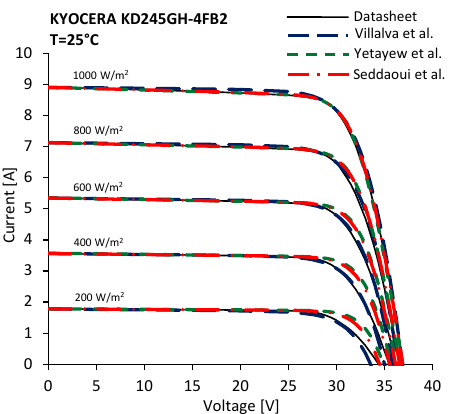
Figure 5. Comparison between the issued I-V characteristics of Kyocera KD245GH-4FB2 at T = 25 ˝ C and